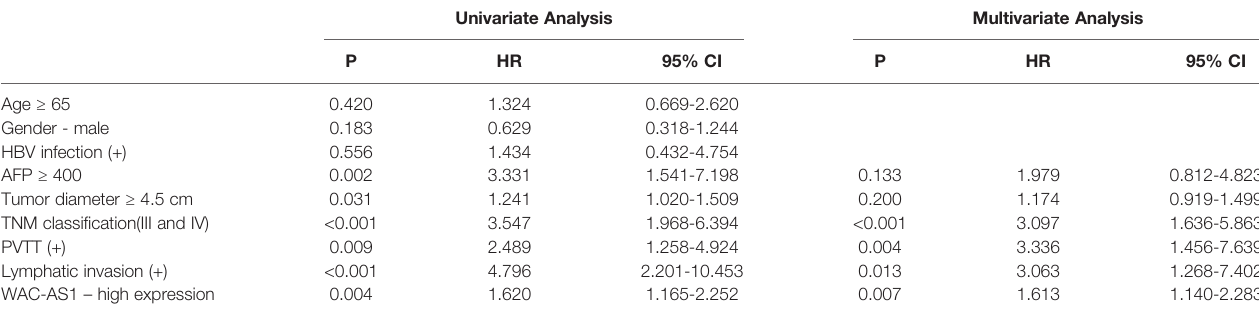
TABLE 2 | Univariate and multivariate Cox-regression analysis of various prognostic parameters in patients with liver cancer. Univariate